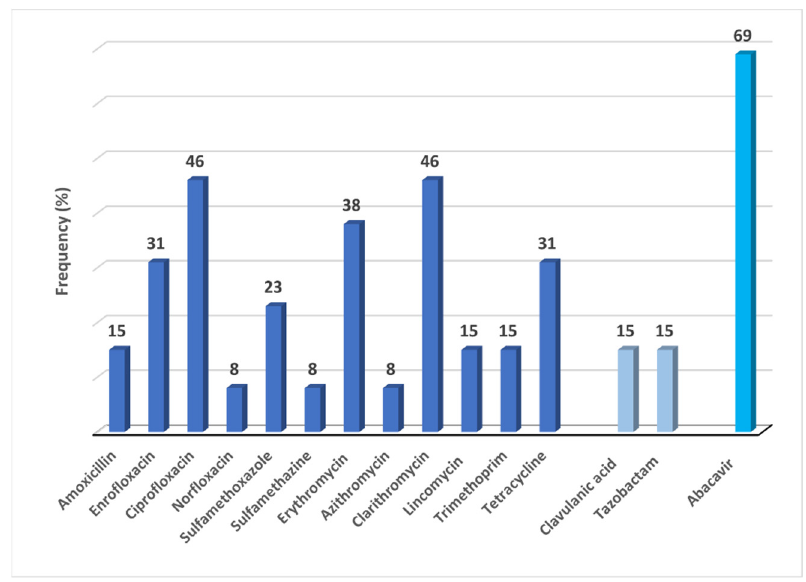
Figure 1. Frequency (%) of antibiotics/ enzyme inhibitors and abacavir detected in surface water.